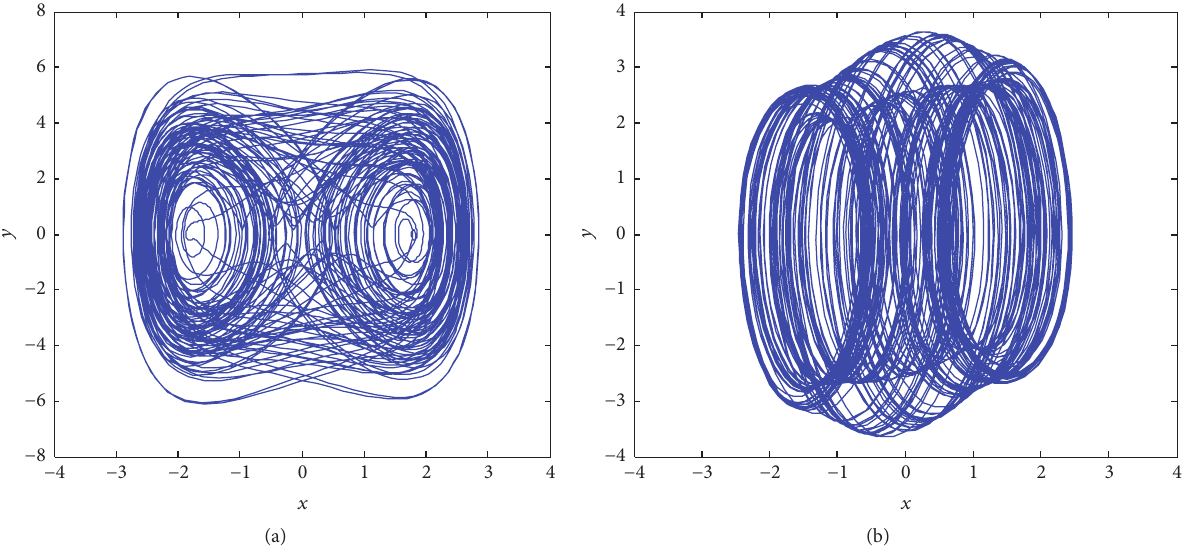
Figure 2: Phase portrait of the chaotic attractor for the 𝜙 6 -Van der Pol oscillator with parameters values (a) 𝜇 = 0.01 , 𝛼 = 0.46 , 𝜔 = 0.86 , 𝑓 = 9.0 , 𝛽 = 1.0 , and 𝜆 = 0.1 for the double-well potentials and (b) 𝜇 = 0.4 , 𝛼 = 1.0 , 𝜔 = 3.14 , 𝑓 = 9.0 , 𝛽 = −0.7 , and 𝜆 = 0.1 , for the triple-well.